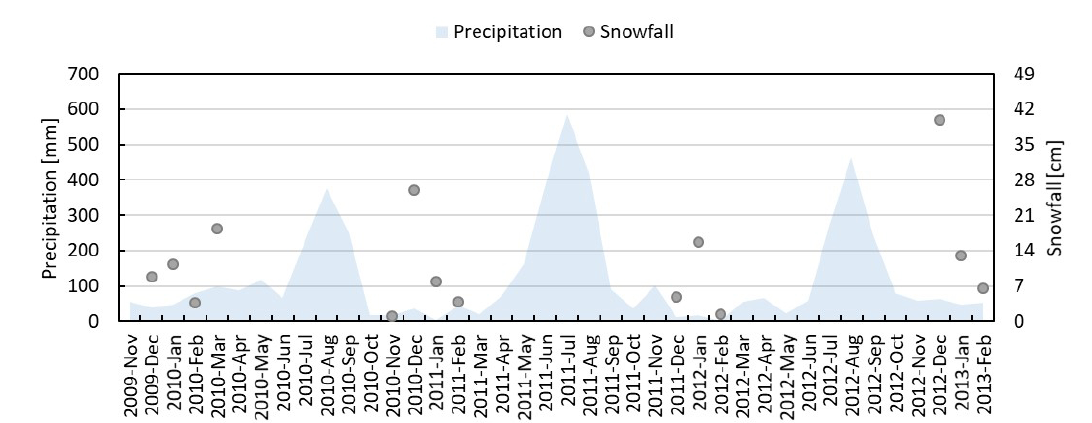
Figure 8. Precipitation and snowfall during operating periods